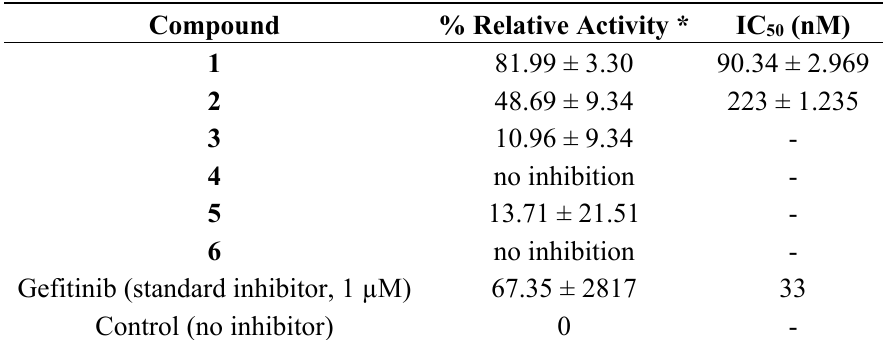
Table 4. The percentage of relative activity of EGFR-tyrosine kinase in the presence of xanthones 1 – 6 (0.01 µM), and the IC 50 values of 1 and 2